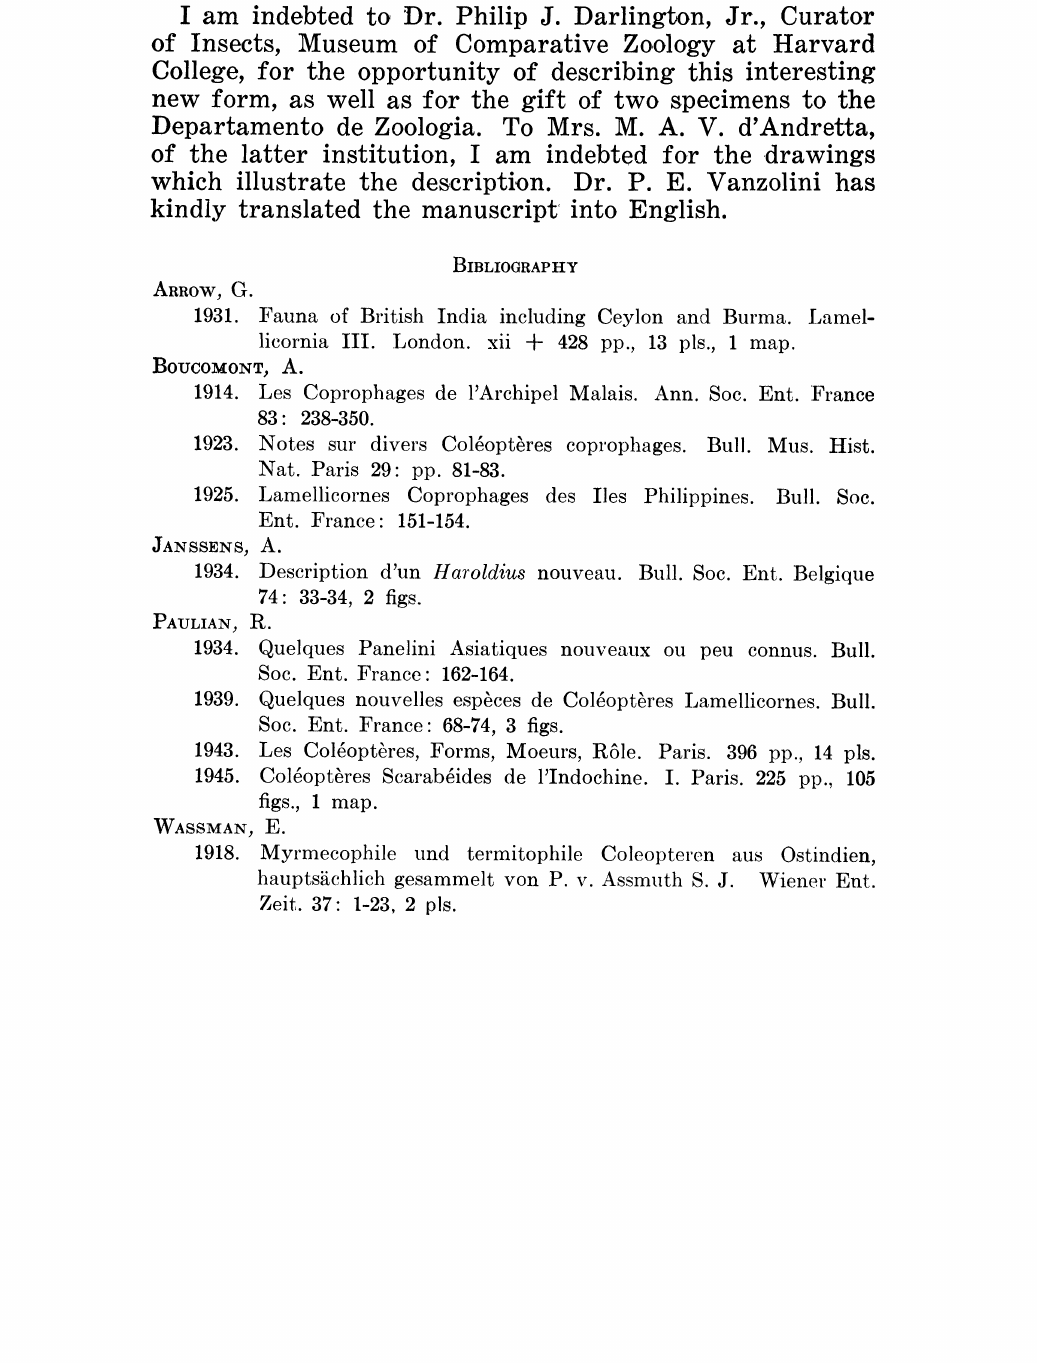
figs., map. WASSMAN,